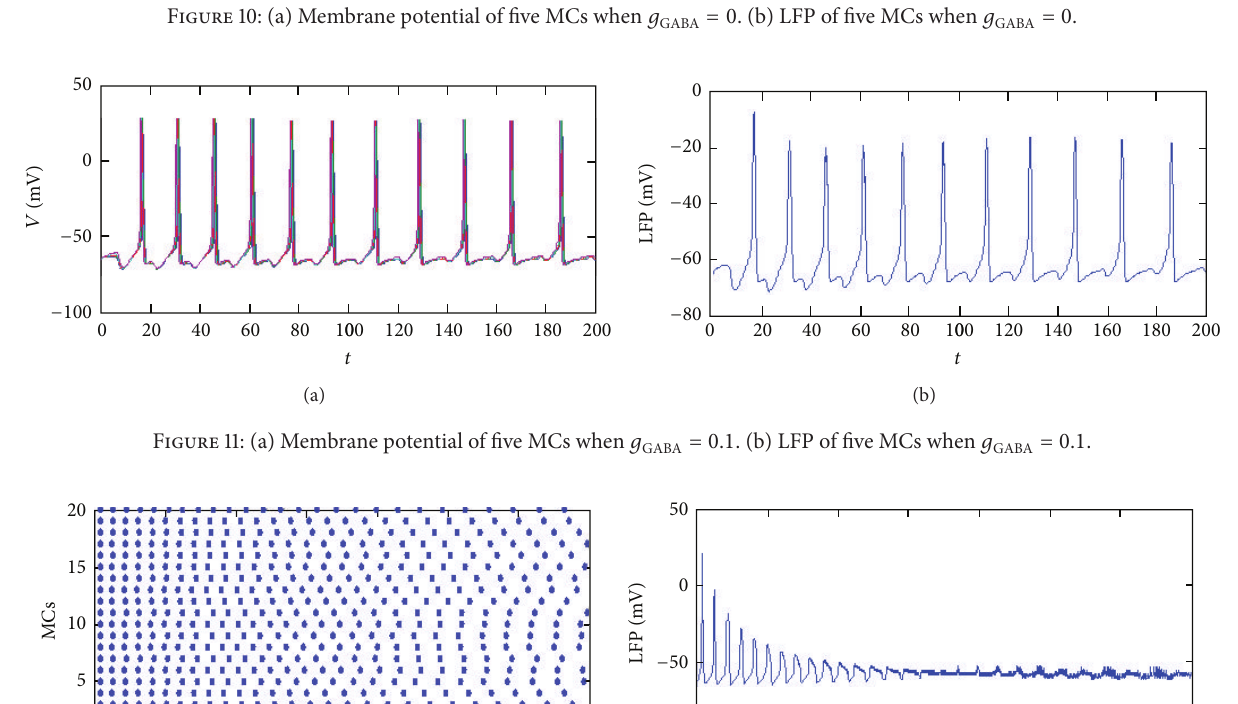
Figure 10: (a) Membrane potential of five MCs when 𝑔